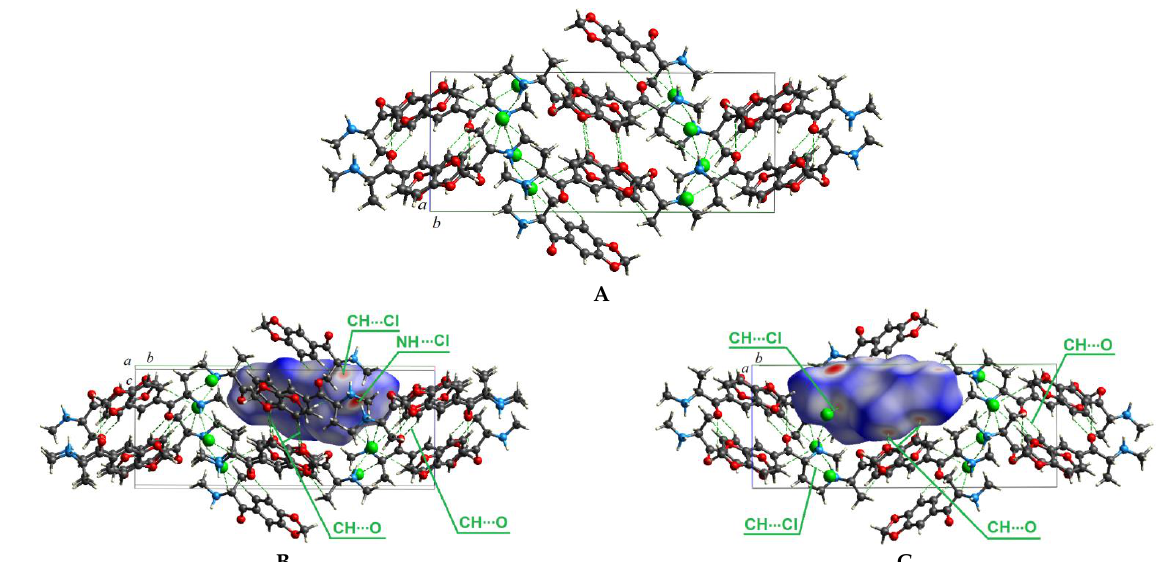
Figure 2. Crystal structure of methylone hydrochloride, intermolecular interactions are shown by green dashed lines ( A ); Hirschfeld d norm surface shows the presence of intermolecular NH---Cl and CH---Cl bonds ( B ); Hirschfeld d norm surface shows the presence of intermolecular CH---O bonds ( C ). The Cl atoms are shown in green, O atoms are in red, N in blue, and C in gray.